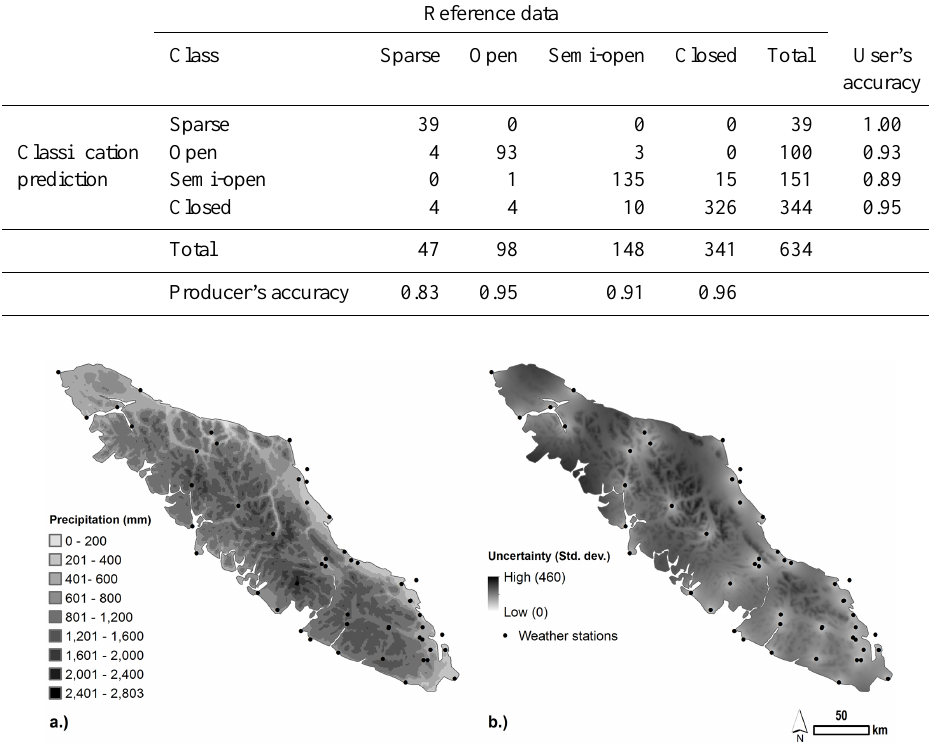
Table 2. Confusion matrix for forest cover classification.